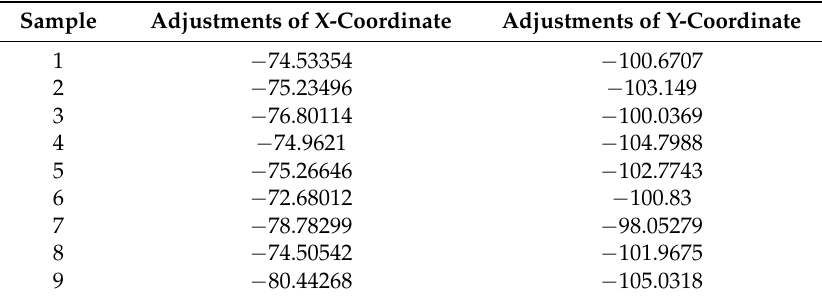
Table 2. Adjustments of the image coordinates.